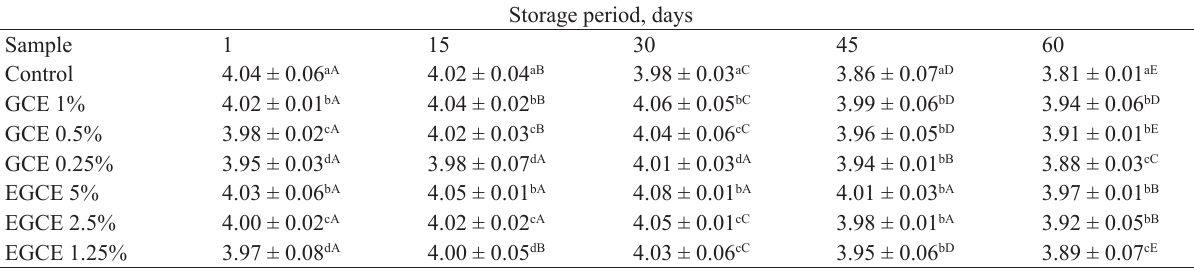
Storage period, days